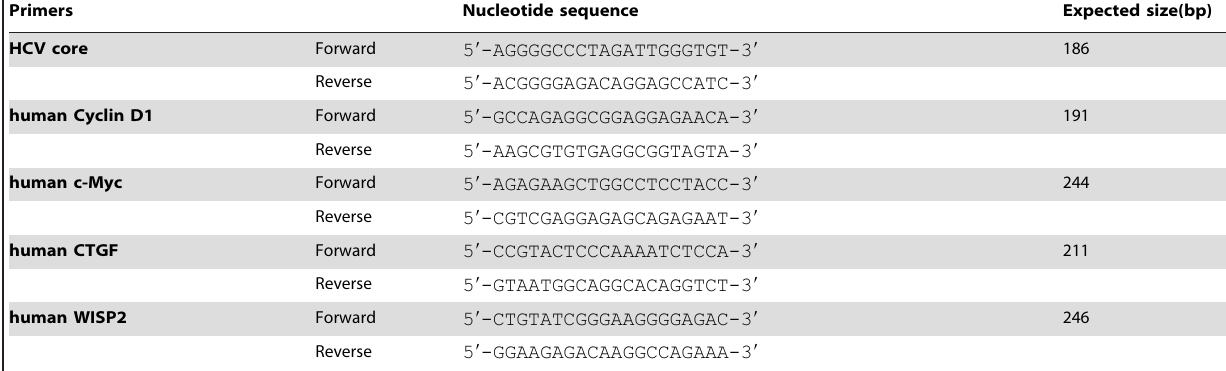
Primers Nucleotide